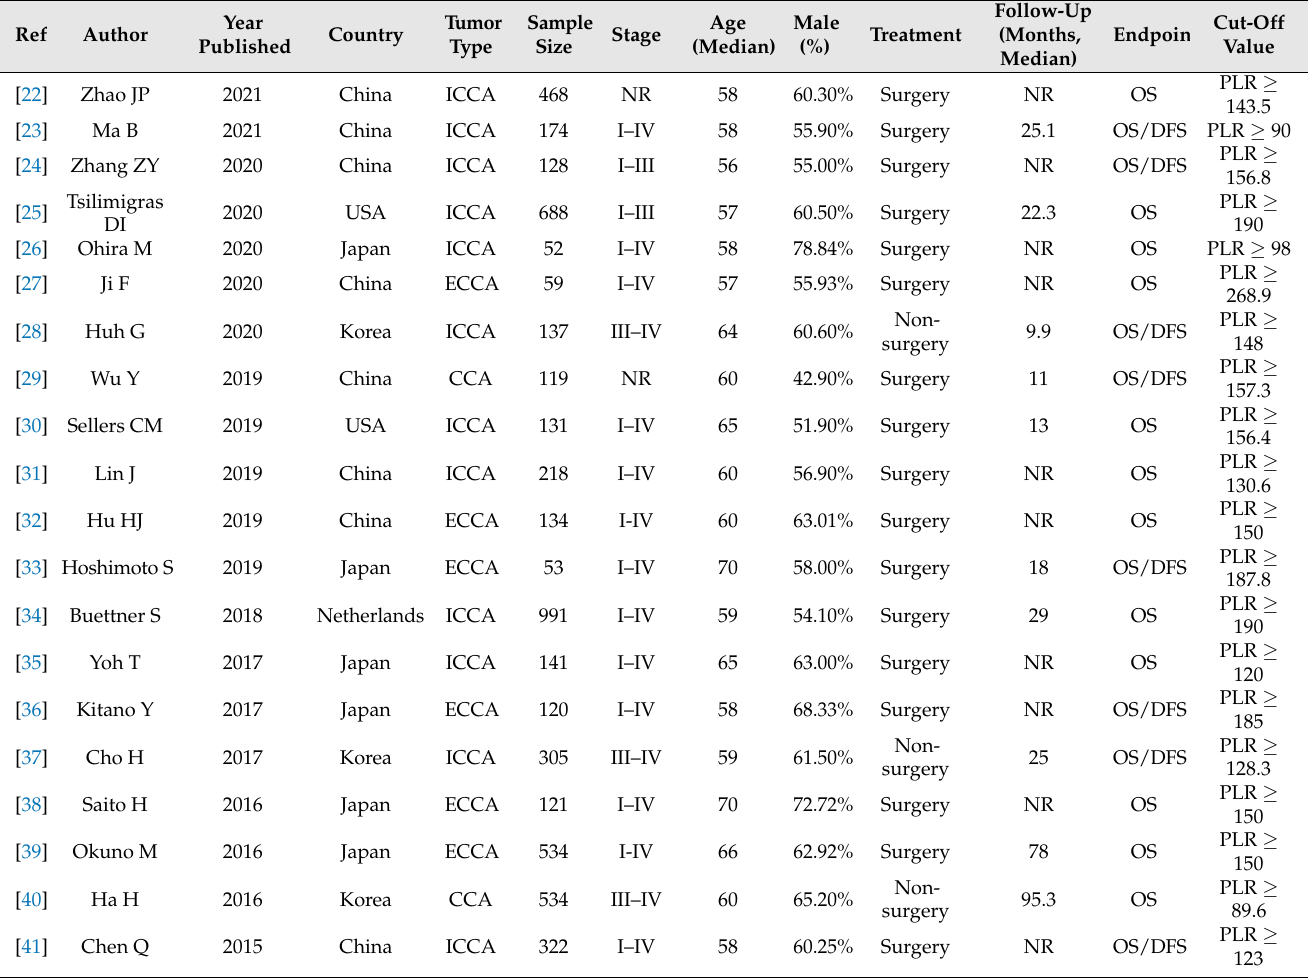
Table 1. Characteristics of the 20 eligible studies evaluating PLR in CCA. CCA, cholangiocar- cinoma; DFS, disease-free survival; ECCA, extrahepatic cholangiocarcinoma; ICCA, intrahepatic cholangiocarcinoma; NR, not reported; OS, overall survival; PLR, platelet-to-lymphocyte ratio; Ref,